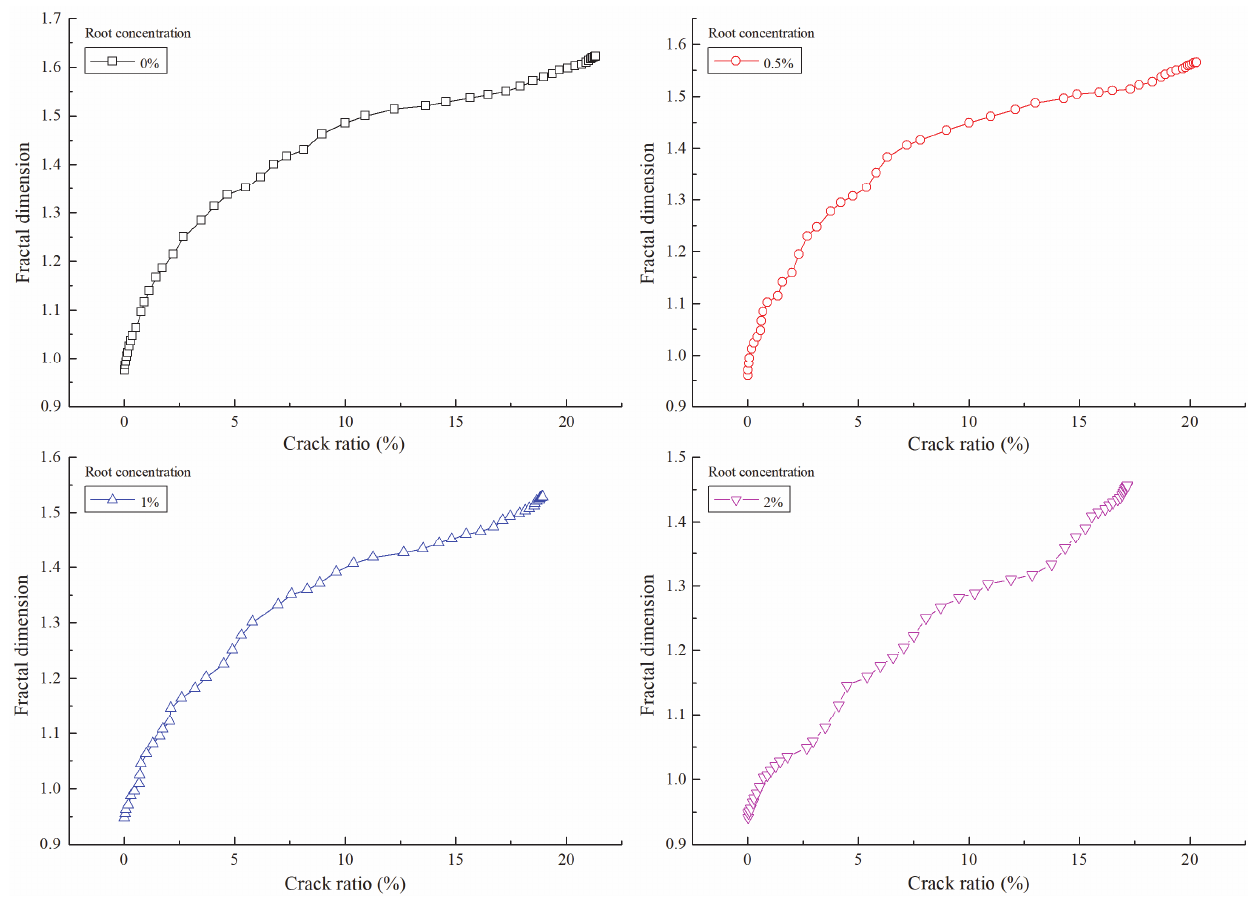
Figure 6. Relationship between crack ratio and fractal dimension.